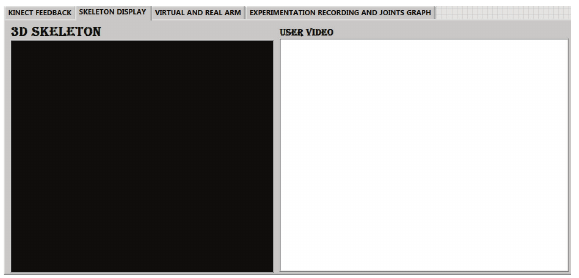
Figure 3: Skeleton and user display screen.